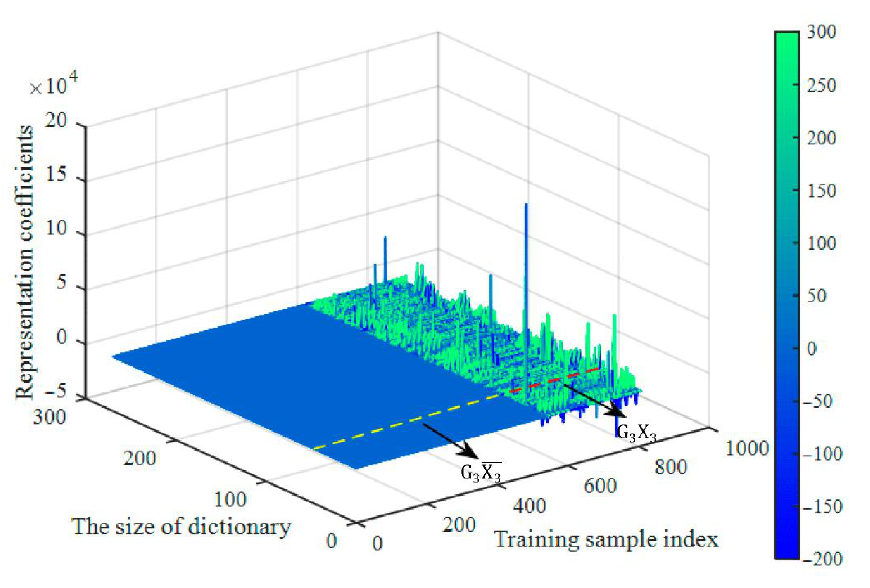
Figure 9. The coefficient matrix.